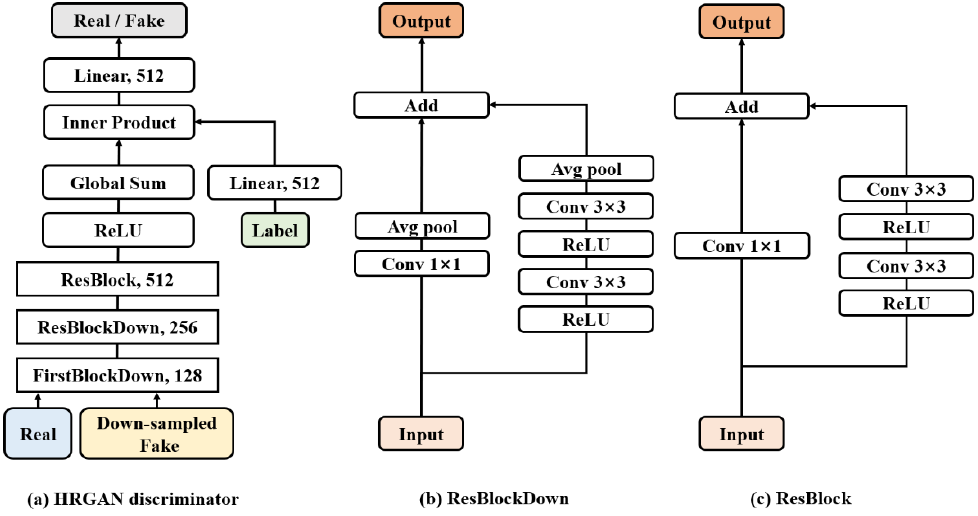
Figure 4. The structures of ( a ) the HRGAN discriminator, ( b ) the down-sampling residual block, and ( c ) the residual block without sampling.